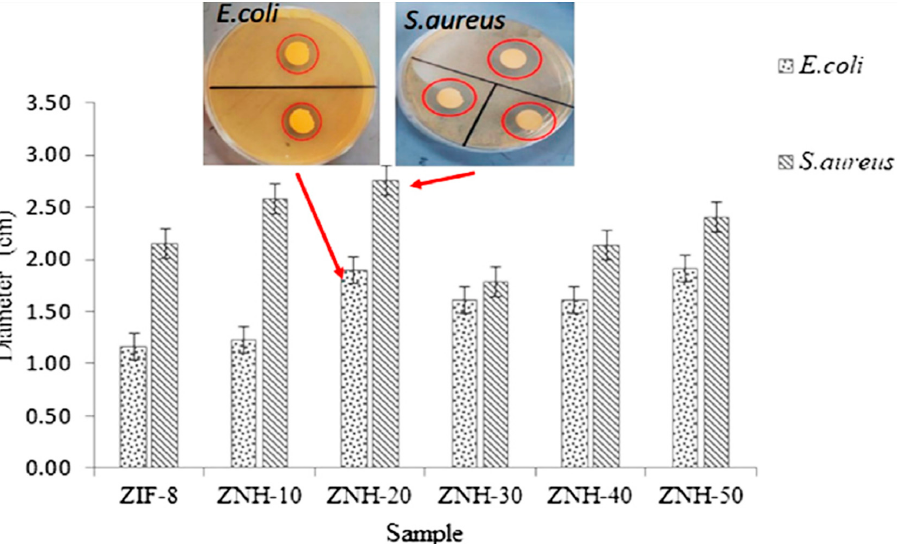
Figure 10. Optical density ( a ) and changes in the turbidity of the solution ( b ) in a cell growth inhibition experiment using INAD against a mixture of E. coli and S. epidermidis. Reprinted from [18] with permission from Elsevier.